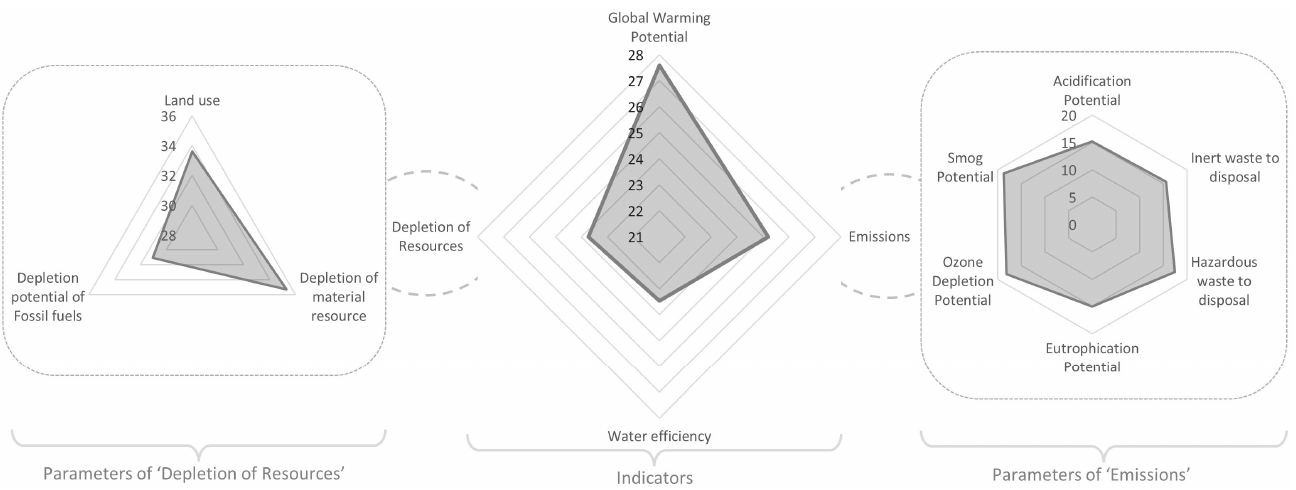
Figure 8. Radar chart for the indicator and parameter weights.